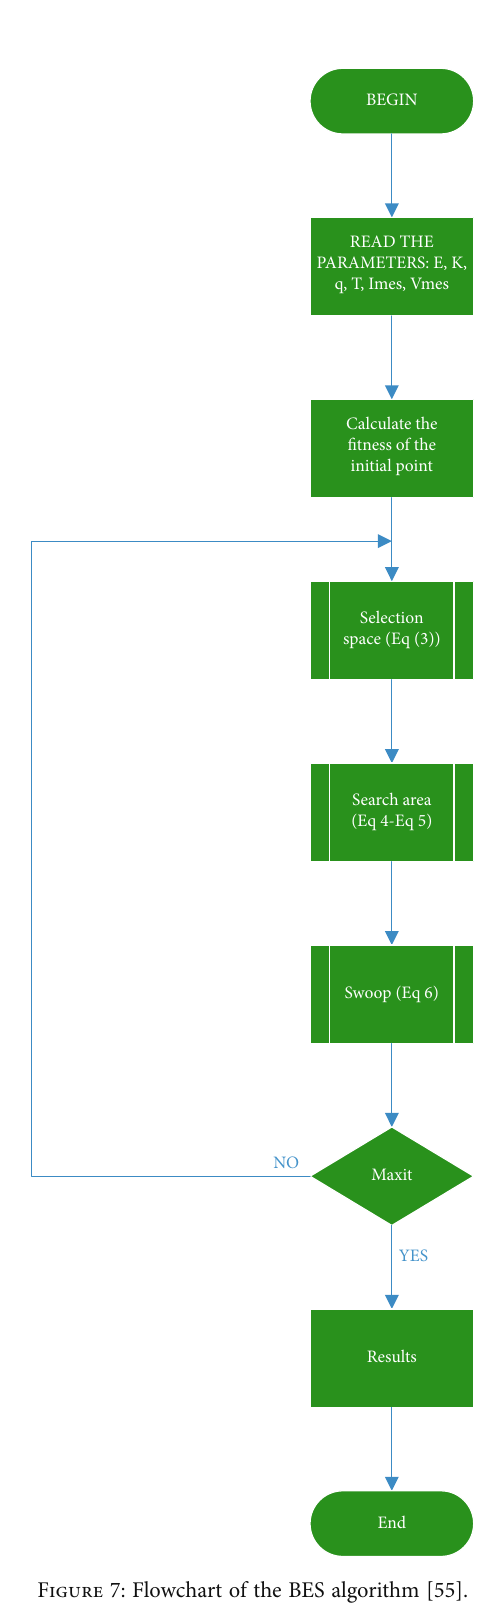
Figure 7: Flowchart of the BES algorithm [55].